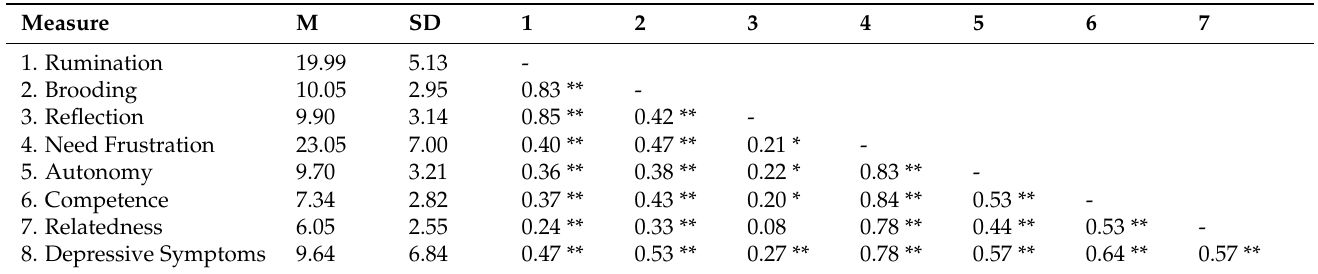
Table 2. Descriptive statistics and correlations for study measures and subscales (N =